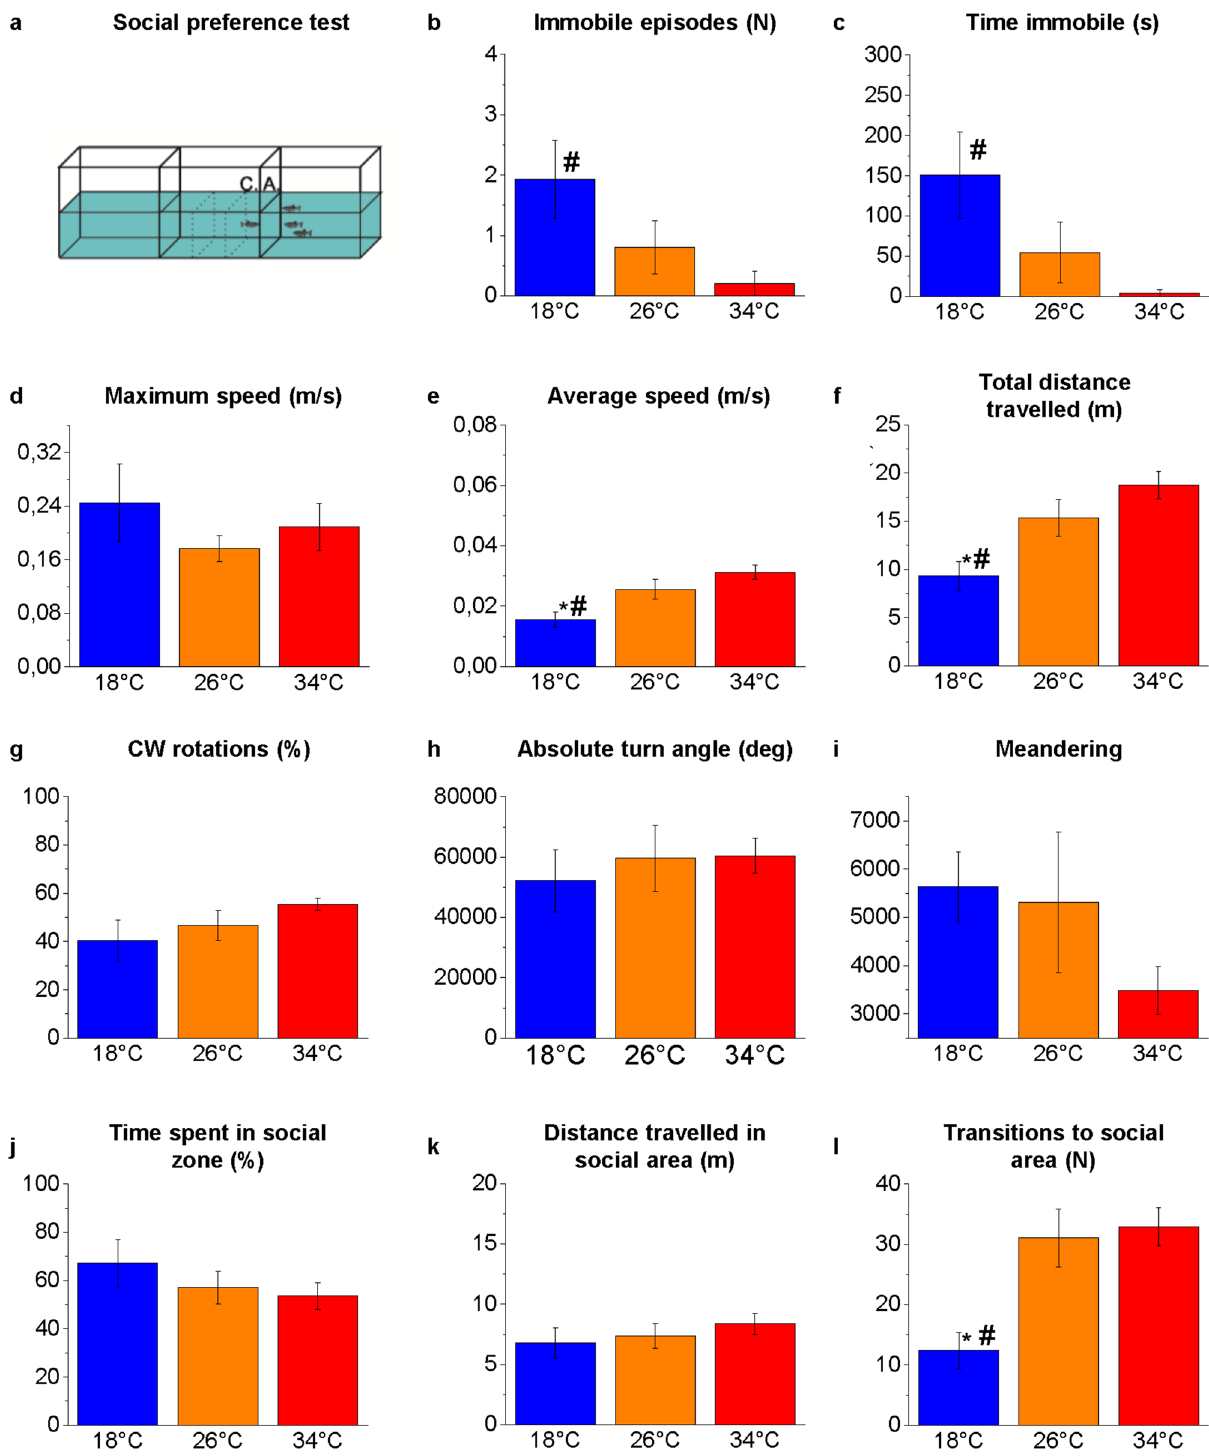
Figure 3. Shoaling behaviour in the SPT. Schematic representation of the apparatus ( a ). Whole tank analysis: immobile episodes ( b ), time immobile ( c ), maximum speed ( d ), average speed ( e ), total distance travelled ( f ), clockwise (CW) rotations ( g ), absolute turn angle ( h ), and meandering ( i ). Conspecific area (C.A.) analysis: time spent ( j ), total distance travelled ( k ), number of entries ( l ). The data are expressed as mean ± S.E.M. and analysed by one-way ANOVA with Bonferroni post hoc correction. P ≤ 0.05, * 18 °C versus 26 °C; # 18 °C versus 34 °C and $ 34 °C versus 26 °C. P values are reported in Table S4. N =